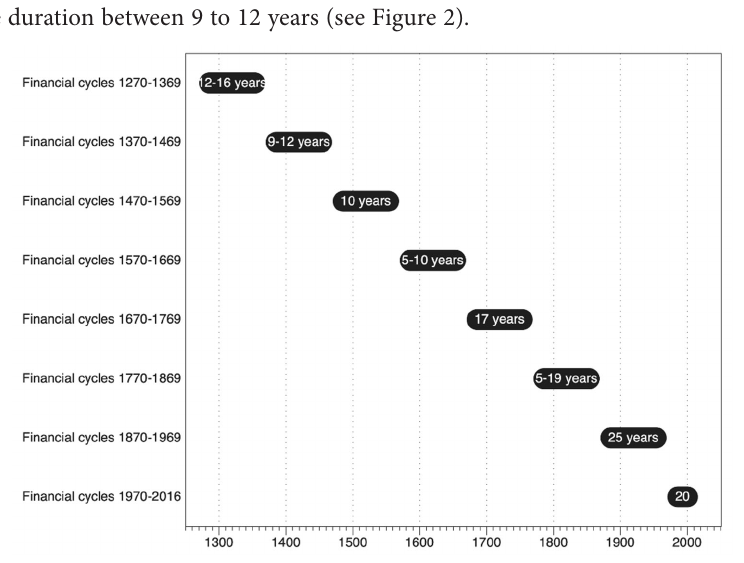
Figure 2. Financial cycles duration in the UK 1270–2016 (source: authors’ calculation) Financial cycles in the UK during the 16th-century show medium volatility and last on average 5 to 10 years. Next century witness longer financial cycles (1670–1769) lasting 17 years on average with medium volatility in financial series. Volatility on housing and credit markets falls during 1770–1869 with an average length of the financial cycles of 5–19 years. Lower amplitudes on the housing and credit markets also hold during 1870–1969 with pro- longed financial cycles duration – 25 years on average. In the last sample period (1970–2016) we see financial cycles turn on volatility once again lasting on average 20 years (including the 2008 financial